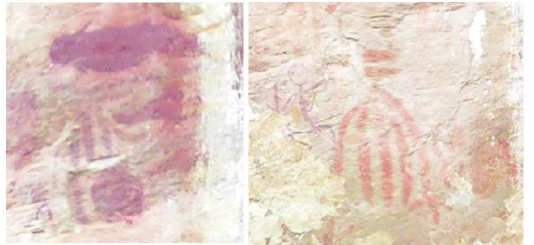
Figure 11: The visualization of the terrestrial laser scanning